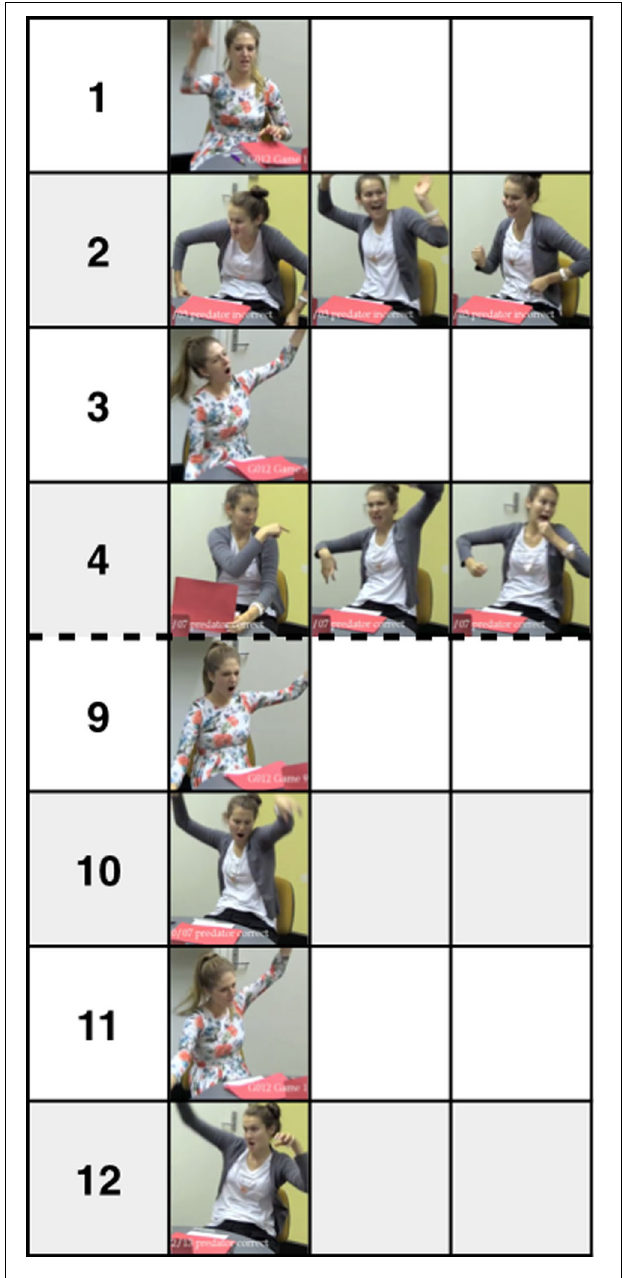
FIGURE 3 | Signs used by a pair in the Gesture modality to communicate the object “predator” at Games 1–4 (Early) and 9–12 (Late). Game number is given in the leftmost column. At Game 1 Director A claws at the air (correctly identified by partner). At Game 2 Director B mimes a hulking movement, with her arms out to the side. Next she throws her arms up in fright before miming a running action (incorrectly